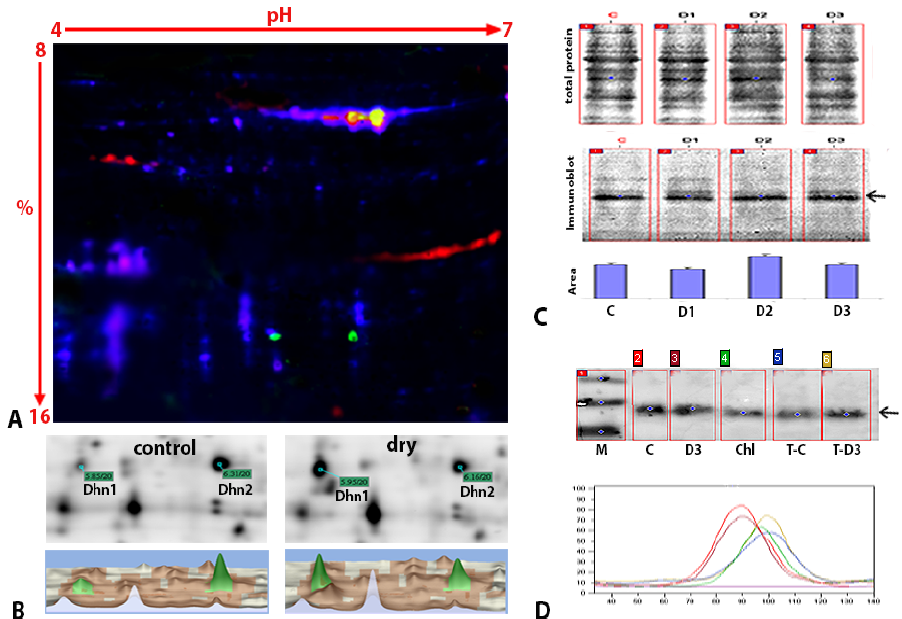
Figure 4. Immunoblot detection and analysis of dehydrins in H. rhodopensis . ( A ) Representative results from the 2D electrophoresis and immunoblotting of dehydrins. Proteins from a crude protein extract (mixture of internal standards for fresh and dry plants) were labeled with Cy5 (blue) and resolved using 2D electrophoresis with an isoelectric point (pI)/MW marker labeled with Cy2 (red). Subsequently, immunoblotting signals were detected with Cy3 (green). ( B ) Results of the 2D electrophoresis and quantitative analysis of proteins from fully hydrated and dry plants. (Upper panel) Representative gels. (Lower panel) 3D “landscape representation” of Dhn1 and Dhn2 from fully hydrated and dry plants with their corresponding relative abundances. ( C ) Immunoblot analysis of dehydrin expression at selected states of desiccation stress. C—watered plants; D1—moderate desiccation; D2—severe desiccation; D3—dry plants. (Upper panel) Resolved leaf protein extracts were stained with MemCode as a protein loading control. (Middle panel) Using anti-dehydrin serum, one 20 kDa protein band was detected (arrow). (Bottom panel) The mean area of each dehydrin band was normalized to the mean area of the total protein stain. Error bars were calculated from triplicate samples. ( D ) (Upper panel) Immunoblot detection of dehydrins in crude protein extracts and chloroplasts. C—watered plants; D3—dry plants; Chl—chloroplasts from watered plants; T-C— thylakoids from watered plants; T-D3—thylakoids from dry plants. (Lower panel) Colored numbers in each lane correspond to colors defining immunosignal